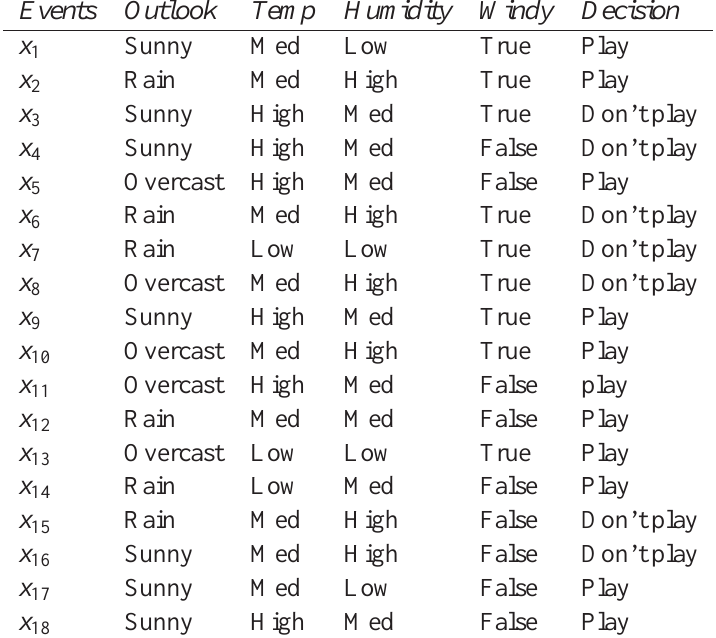
Table 1: A decision information